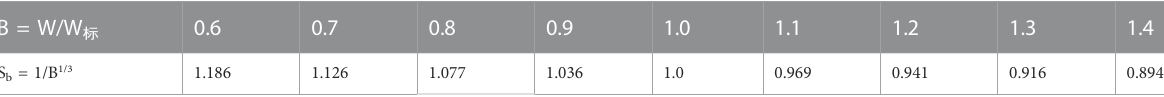
TABLE 1 Calibration coef fi cients for animals of non-standard weight (S b ). B = W/W